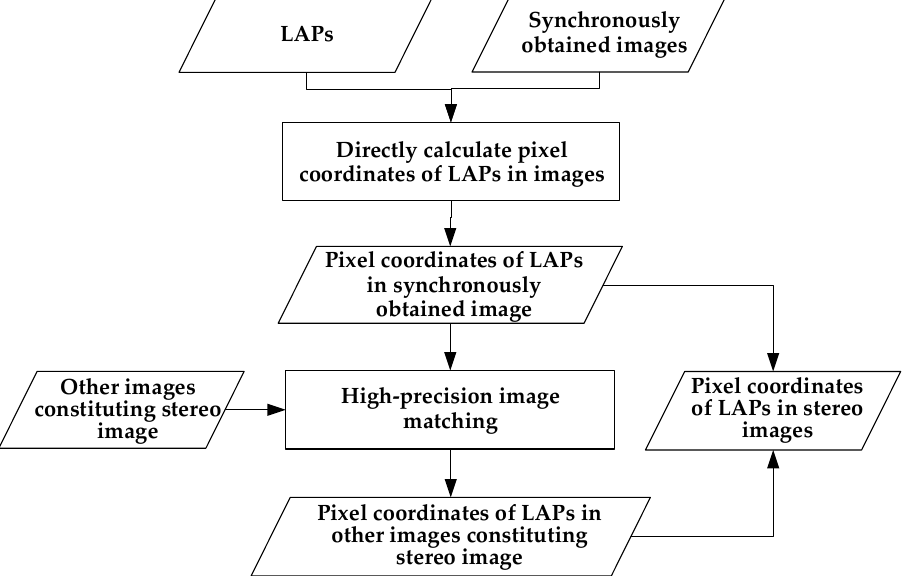
Figure 5. Measurement of LAPs without footprint image.